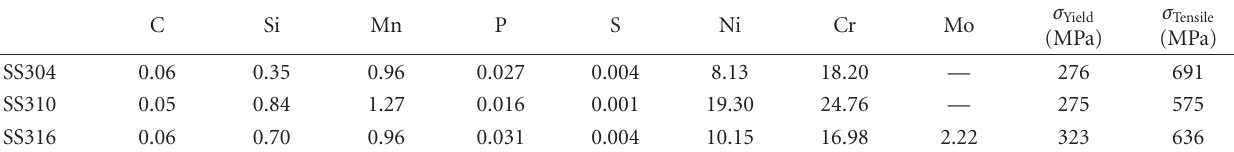
Table 1: Chemical compositions (wt%) and mechanical properties of the austenitic stainless steels used.